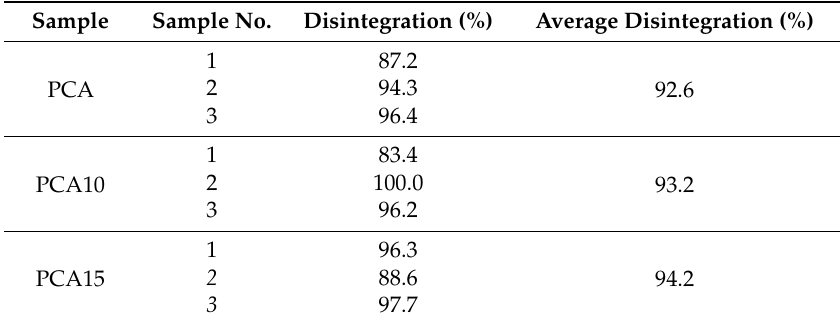
Table 2. Average percentage of disintegration after 90 days under simulated composting conditions. Sample